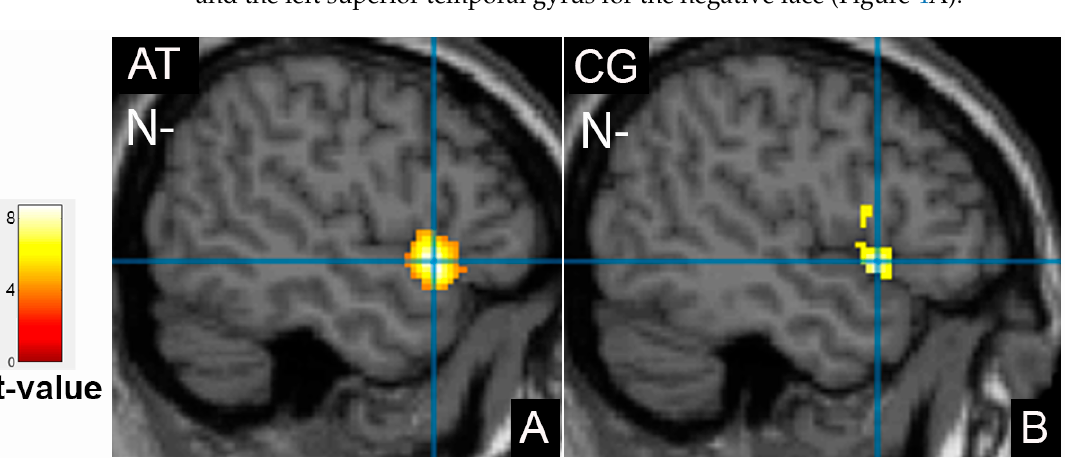
Figure 4. Activation of the left superior temporal gyrus in patients after therapy (AT) ( A ) and in healthy controls (CG) ( B ) on demonstration of negative faces (N ‐ ).